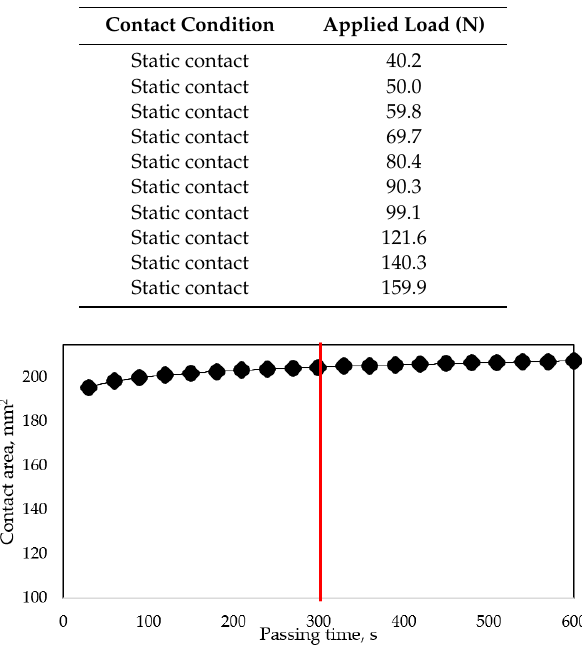
Figure 4. Rubber-wheel deformation due to elapsed time.